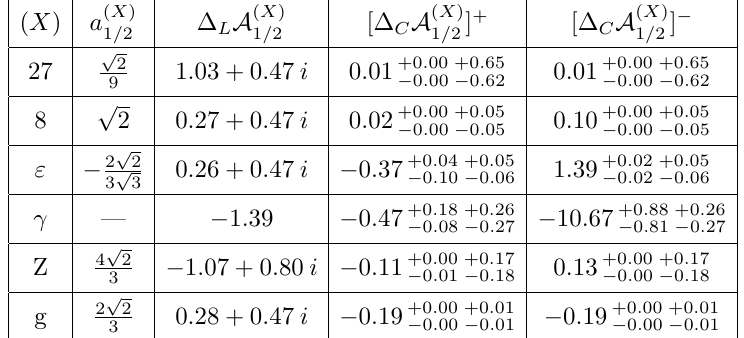
. The two uncertainties in the local 1 = 2